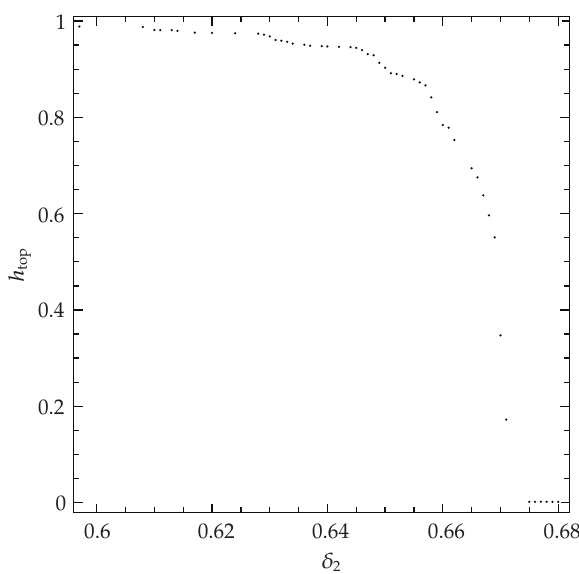
Figure 7: Variation of the topological entropy for δ 2 ∈ (cid:5) 0 . 585 , 0 . 686 (cid:6) , with (cid:3) (cid:7) 0 .